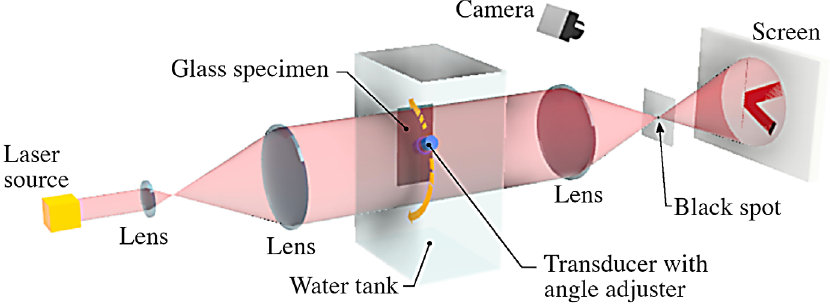
Figure 1. Schematic of the Schlieren setup employed in this work.